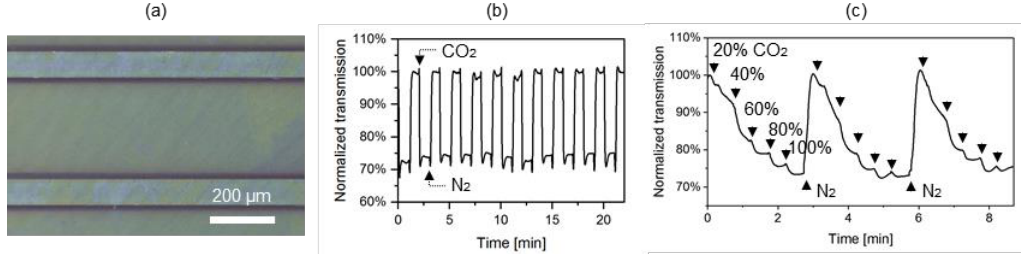
Fig. 1 (a) Microscope image of ZIF-8-coated polymer optical waveguide, which exhibits green color under optical microscope. (b) Dynamic response of ZIF-8-coated waveguide sensor to CO 2 . (c) Dynamic response of ZIF-8-coated waveguide sensor to CO 2 with different